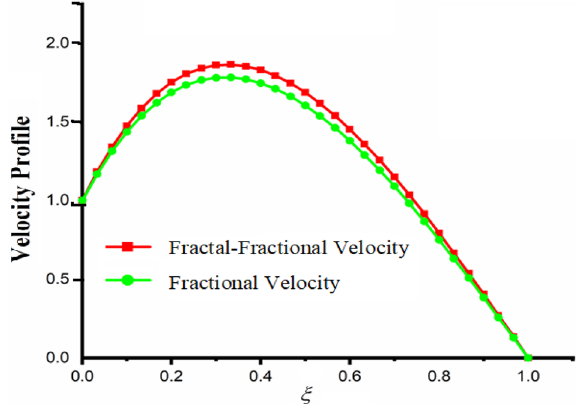
Figure 4. The comparison of fractal-fractional CSF velocity with fractional CSF velocity in channel when, α = 0.5 , β = 0.5 , Gr = 2 , Gm = 3 , M = 2 , K = 3 , η A = 1 , P = 1.5 , Pr = 1.5 , Re = 2.5 and Sc = 0.3